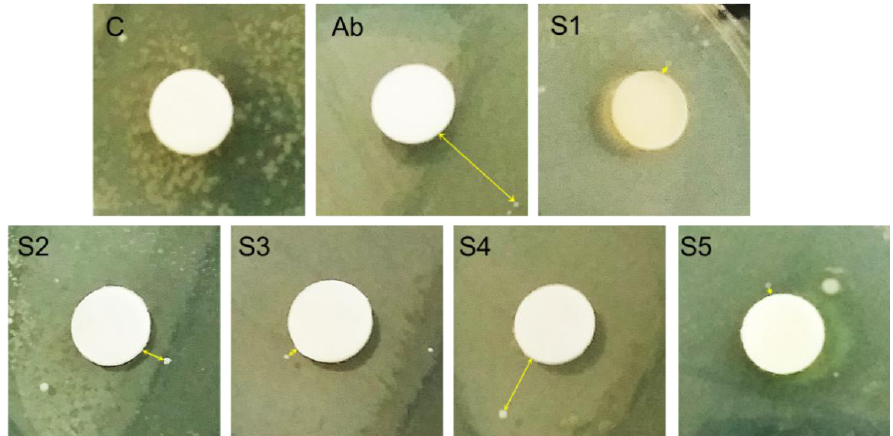
that of smallest spherical AgNPs (S4).